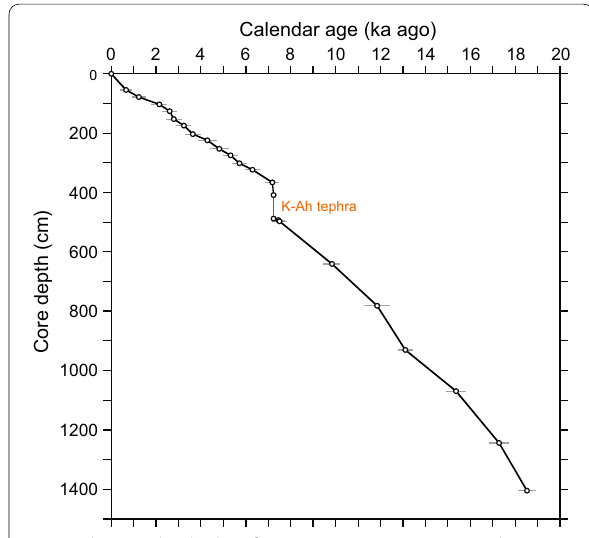
Fig. 2 The age-depth plot of Core KY07-04 PC01. Open circles denote radiocarbon dates (calibrated to calendar age) of planktic foraminifera with error bars ( 1 σ ). Orange vertical line indicates K-Ah ± tephra stratum. The K-Ah tephra datum